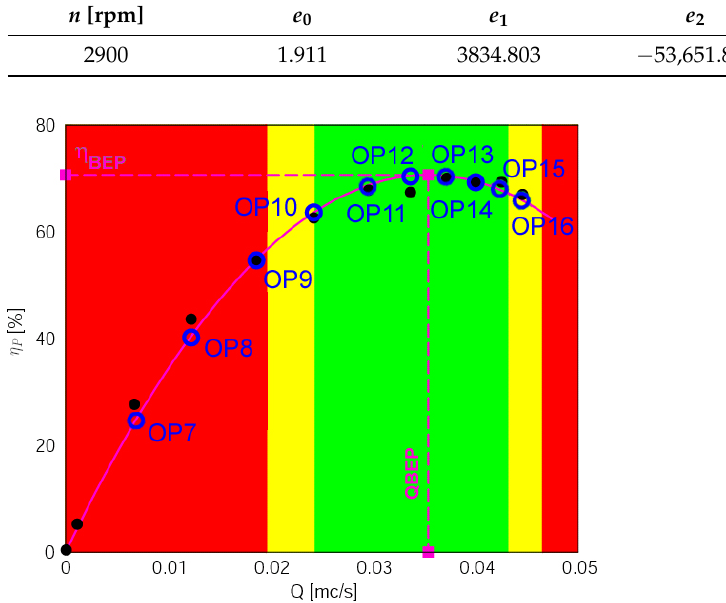
Figure 5. The validation of the software module for the pump’s full operating